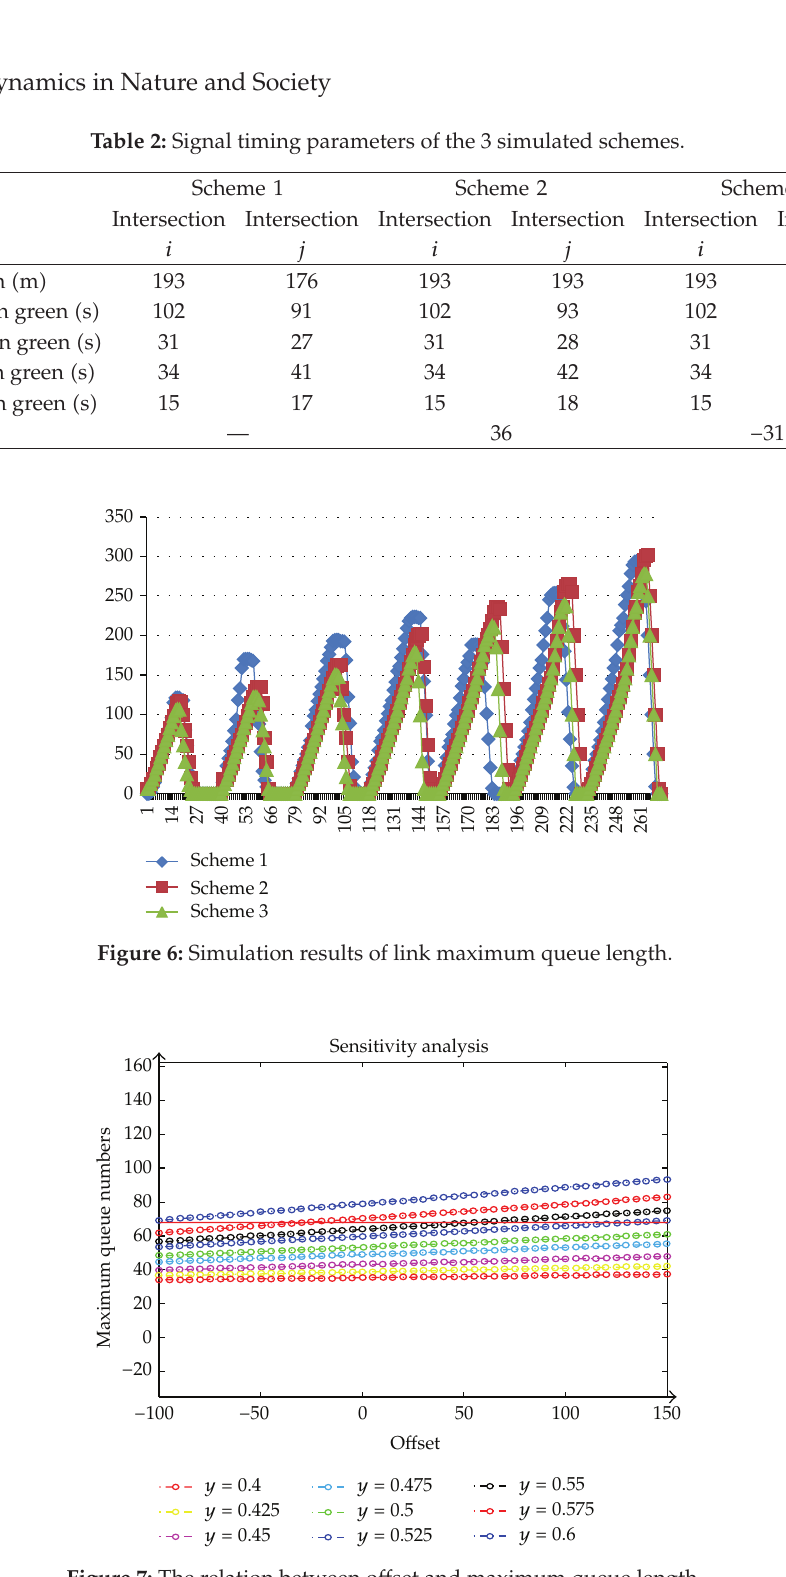
Figure 7: The relation between o ff set and maximum queue